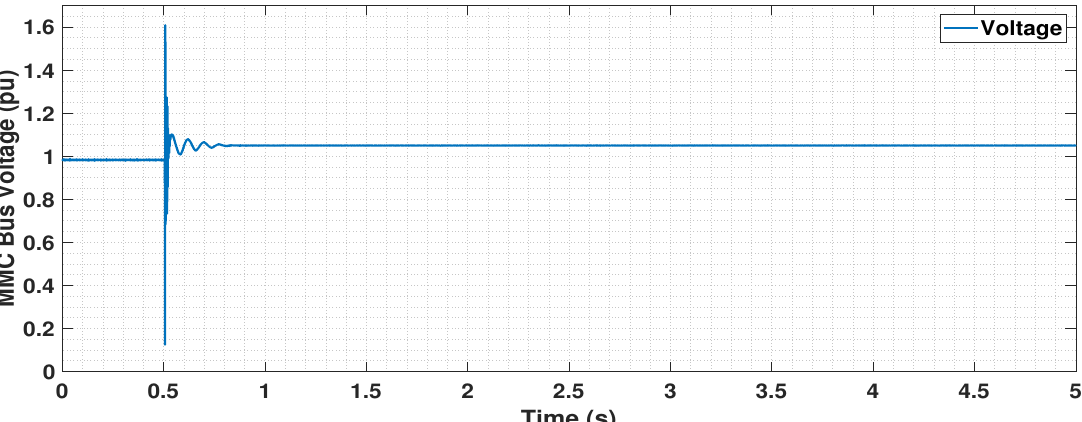
Figure 17. Voltage at MMC bus upon charging of cable-1.